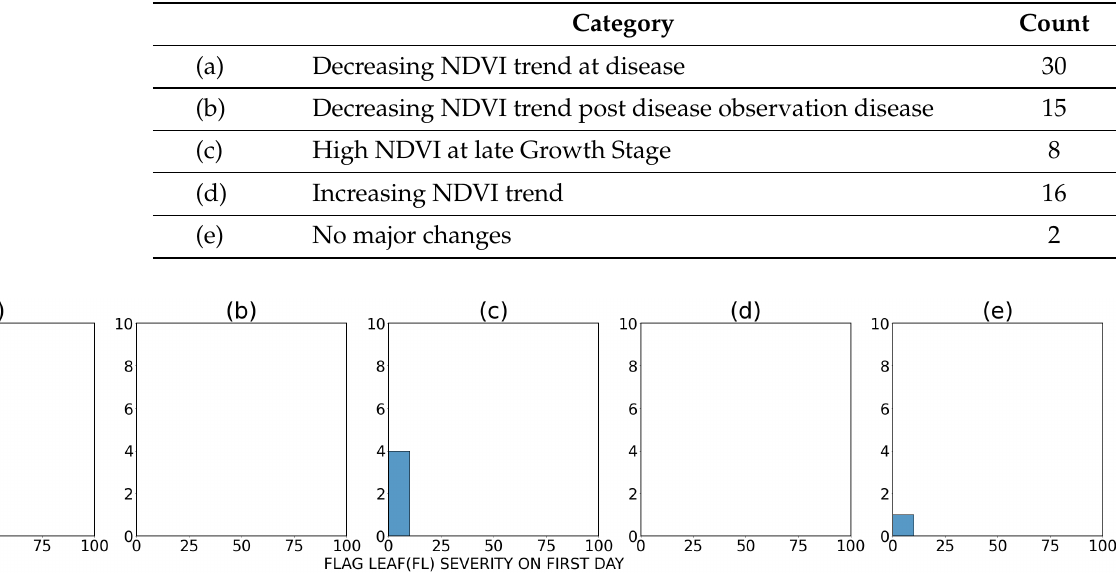
Figure 10. Flag leaf level yellow rust severity on the first day of disease observation. The horizontal axis represents the intensity of the severity and the vertical axis represents the count of trials in each categories, where ( a ) Decreasing NDVI trend at disease, ( b ) Decreasing NDVI trend post disease observation disease, ( c ) High NDVI at late Growth Stage, ( d ) Increasing NDVI trend, ( e ) No major